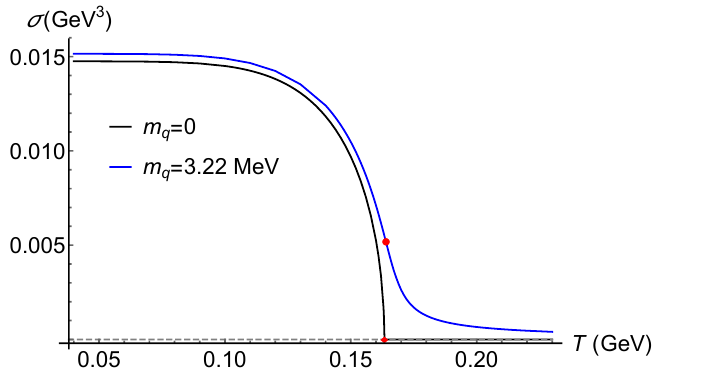
Figure 1 . Chiral condensate σ as a function of temperature T in the chiral limit ( m q = 0 , the black curves) and with the physical quark mass ( m q = 3 . 22 , the blue curve). The red circles represent the critical point ( T c ) of the second order phase transition and the crossover point ( T cp ), which is identified as the fastest decreasing point of σ , i.e., d 2 σ/dT 2 | T = T T c = 0 . 163 GeV and T cp = 0 . 164